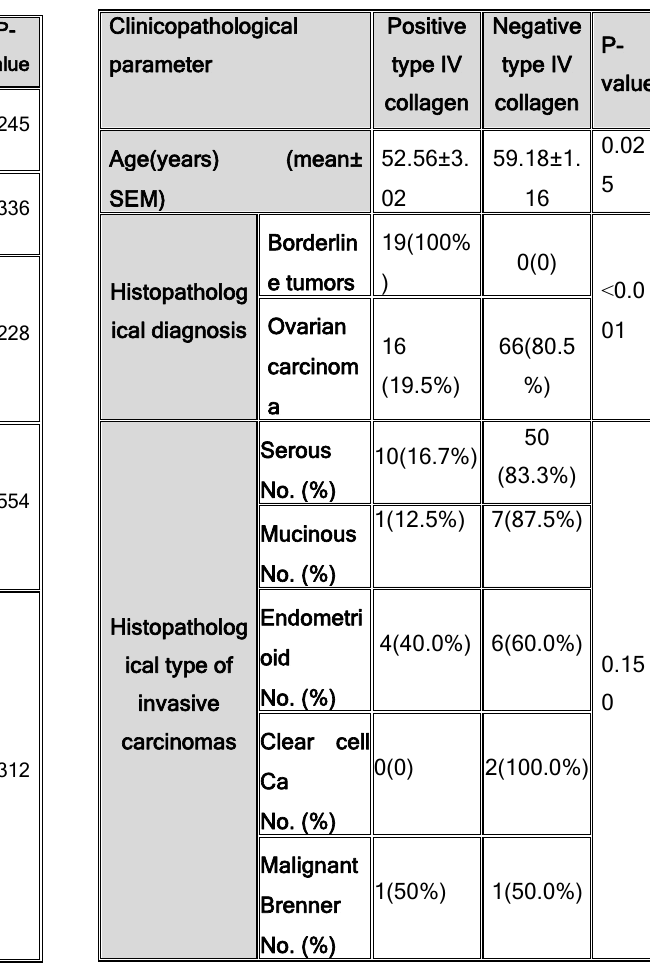
Table 2: Association of CD44v6 immunohistochemical expression with clinicopathological parameters of borderline tumors, and ovarian